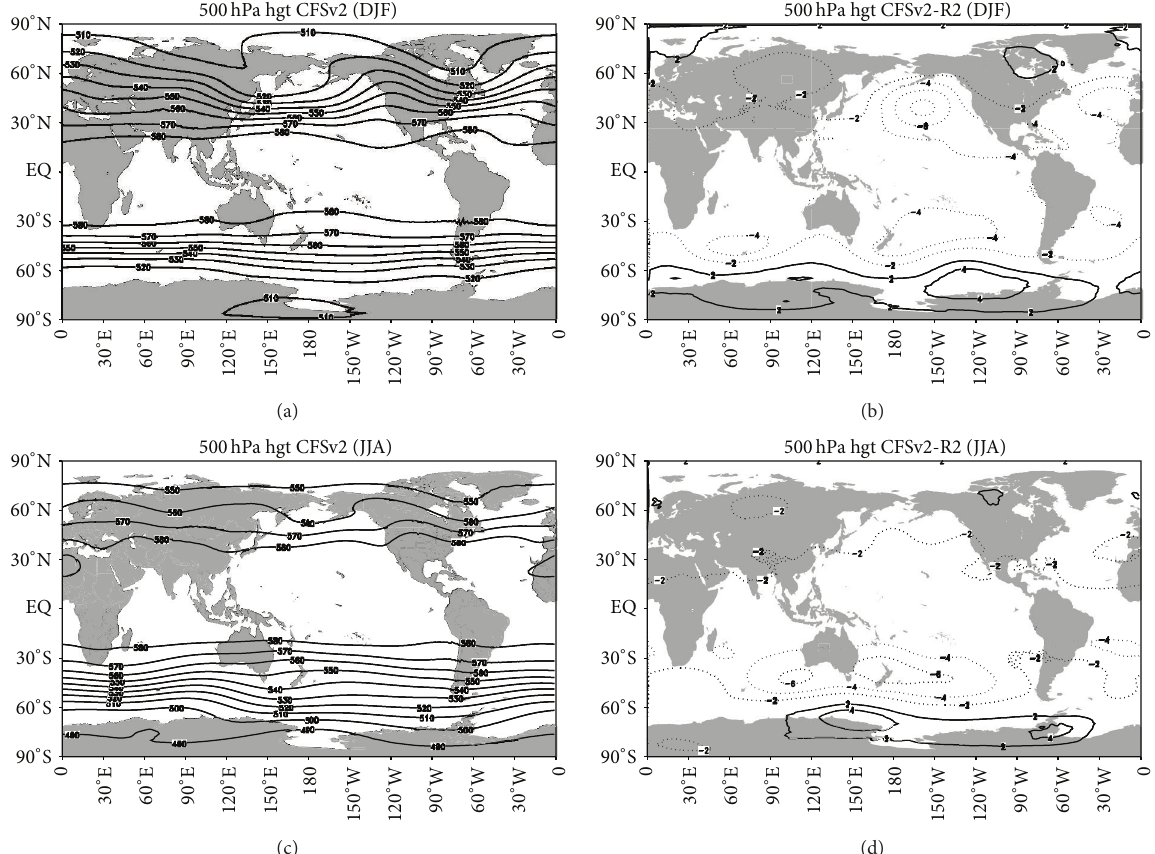
Figure 7: As in Figure 5, but for mean geopotential height at 500hPa. Contours interval is 10gpm in (a) and (c) and 2 gpm in (b) and (d). Negative contours are